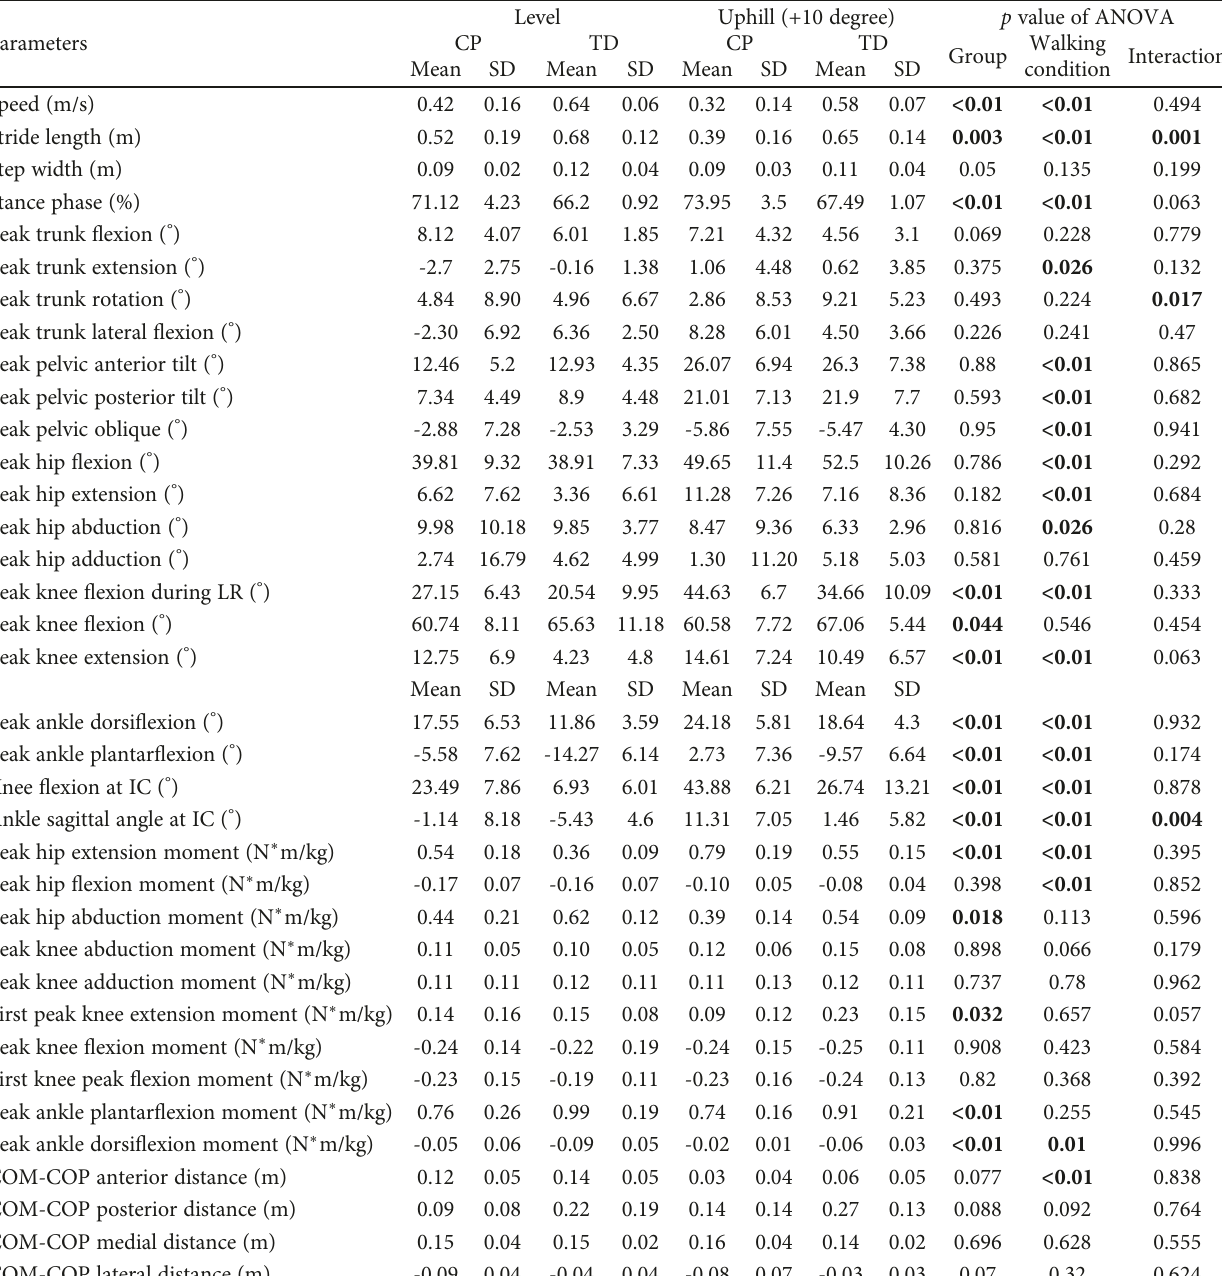
Table 3: Descriptive statistics for key gait variables of CP and TD children under two walking conditions (level and uphill treadmill walking) and results of two-way ANOVA for di ff erences in the group (CP or TD children), walking condition, and group ∗ walking condition